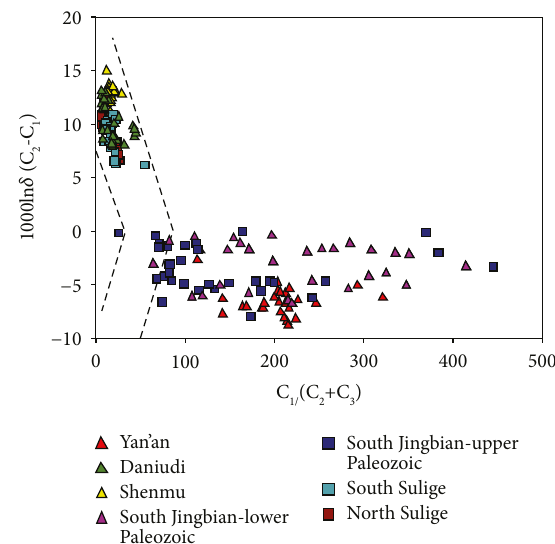
Figure 9: Plot of isotopic separation 1000ln( σ (C +C ), where σ = 1000 + δ 13 C ‐ C C2 – C1 2 3 (modi fi ed after Zeng et al., 2008, the dashed line indicated the expected trend for gas generated by abiotic